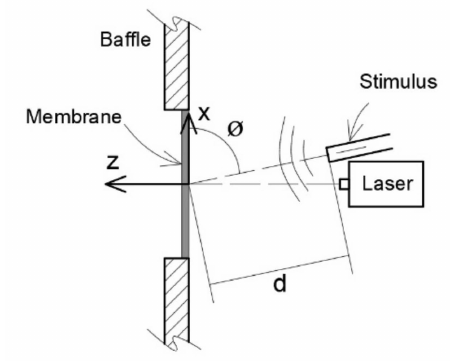
Figure 1. Configuration